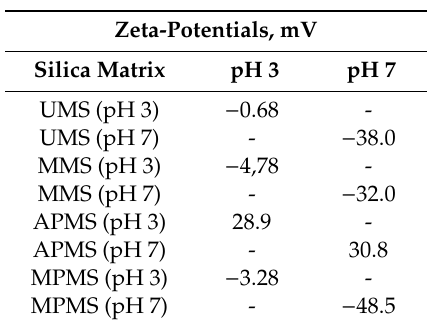
Table 3. Zeta potentials of synthesized silica matrixes in water-ethanol solutions (40%, v / v ) with pH 3 and 7.